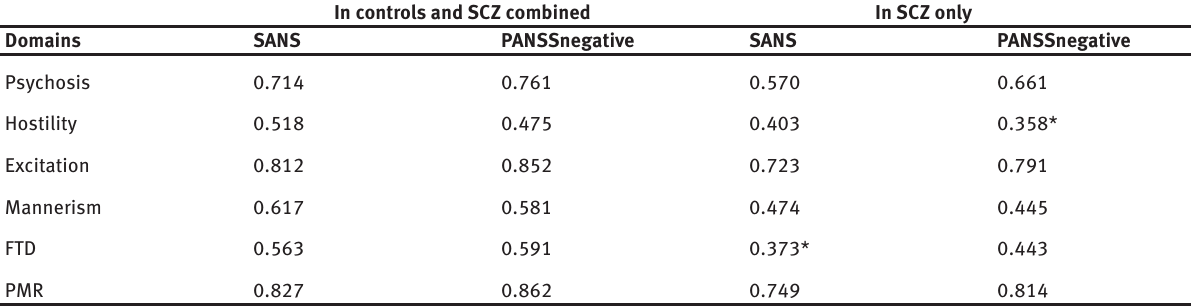
In controls and SCZ